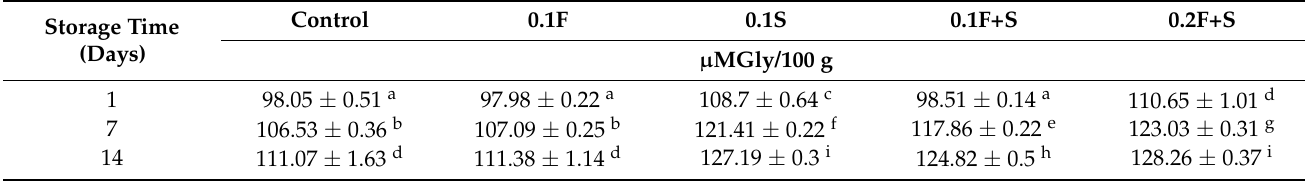
Table 5. Free amino groups content in yoghurt ( µ mol Gly/100 g) during storage.